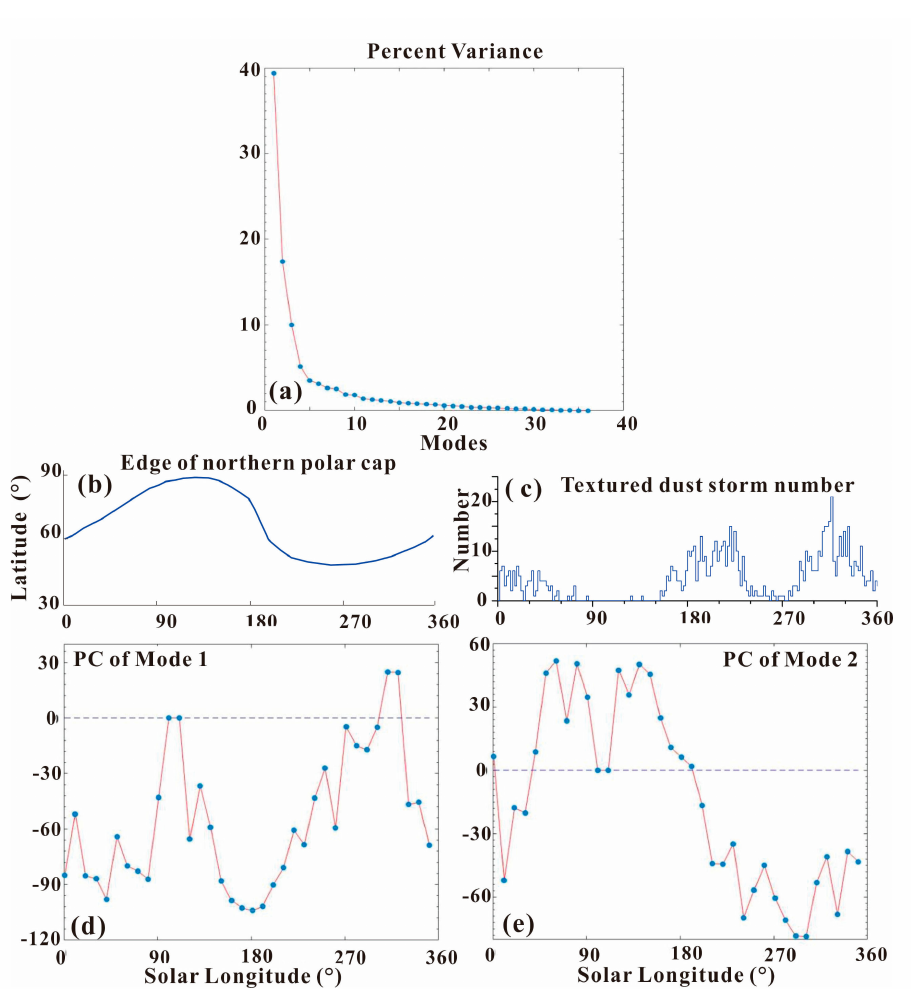
Figure 10. ( a ) The total variance percentage in dust storm activity within the 1600 km-radius ring of the Chryse Planitia interpreted by every EOF mode. ( b ) The average latitude of the Arctic polar cap edge in its respective seasons. ( c ) The daily number of textured dust storms within Chryse’s 1600 km-radius ring. The principal components of EOF Mode 1 ( d ) and Mode 2 ( e ) demonstrate those modes’